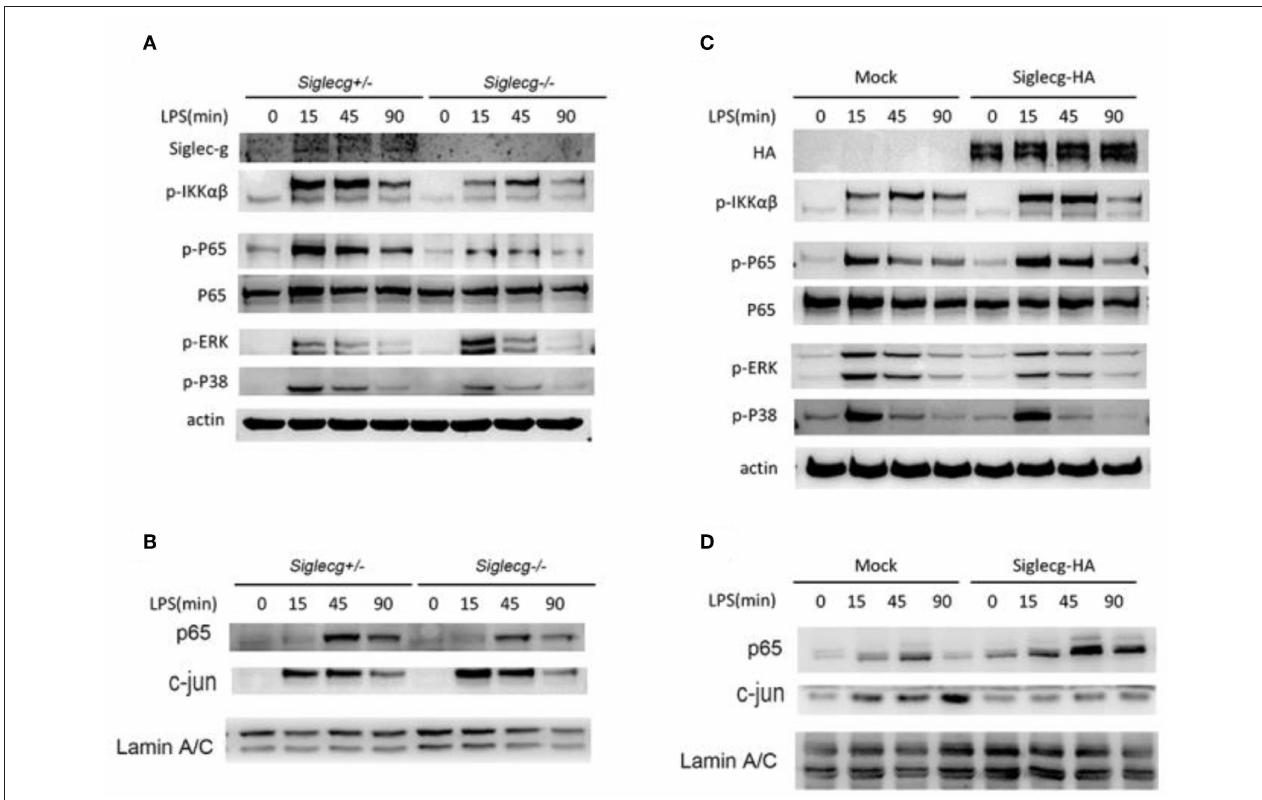
FIGURE 3 | Siglec-G orchestrates NF- κ B and ERK activation. (A,B) Immunoblotting of cell lysates (A) or nuclear extract (B) from Siglecg + / − and Siglecg − / − 2 × 10 6 peritoneal macrophages stimulated with LPS (100ng/ml) for the indicated time with indicated antibodies. (C,D) Immunoblotting of cell lysates (C) or nuclear extract (D) from Siglec-G overexpressing RAW264.7 cells (3 × 10 6 ) stimulated with LPS (100ng/ml) for the indicated time with indicated antibodies. Data are representative of three independent experiments with similar results. ERK, extracellular signal-regulated kinase; LPS,